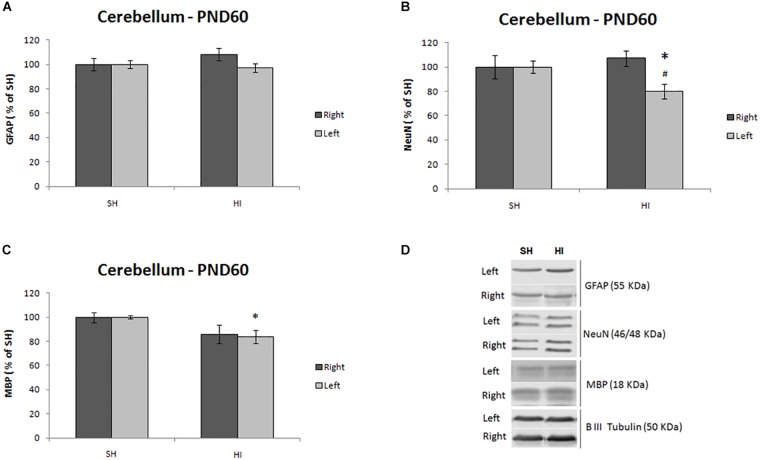
Summary of protein expression of astrocytes (GFAP, A), neurons (NeuN, B), and myelin (MBP, C) in both hemispheres of the cerebellum in adult rats (PND60) after HI or SH at PND3. The representative blots for the NeuN, GFAP, and MBP, for SH and HI groups, were shown in panel (D). Western blotting results are plotted normalized to SH expression level (100%) (mean ± SEM). “∗” Stands for difference between HI and SH (n = 6–8 animals per group), and “#” represents difference between right and left hemispheres. Significance was determined using unpaired t-test when p < 0.05.